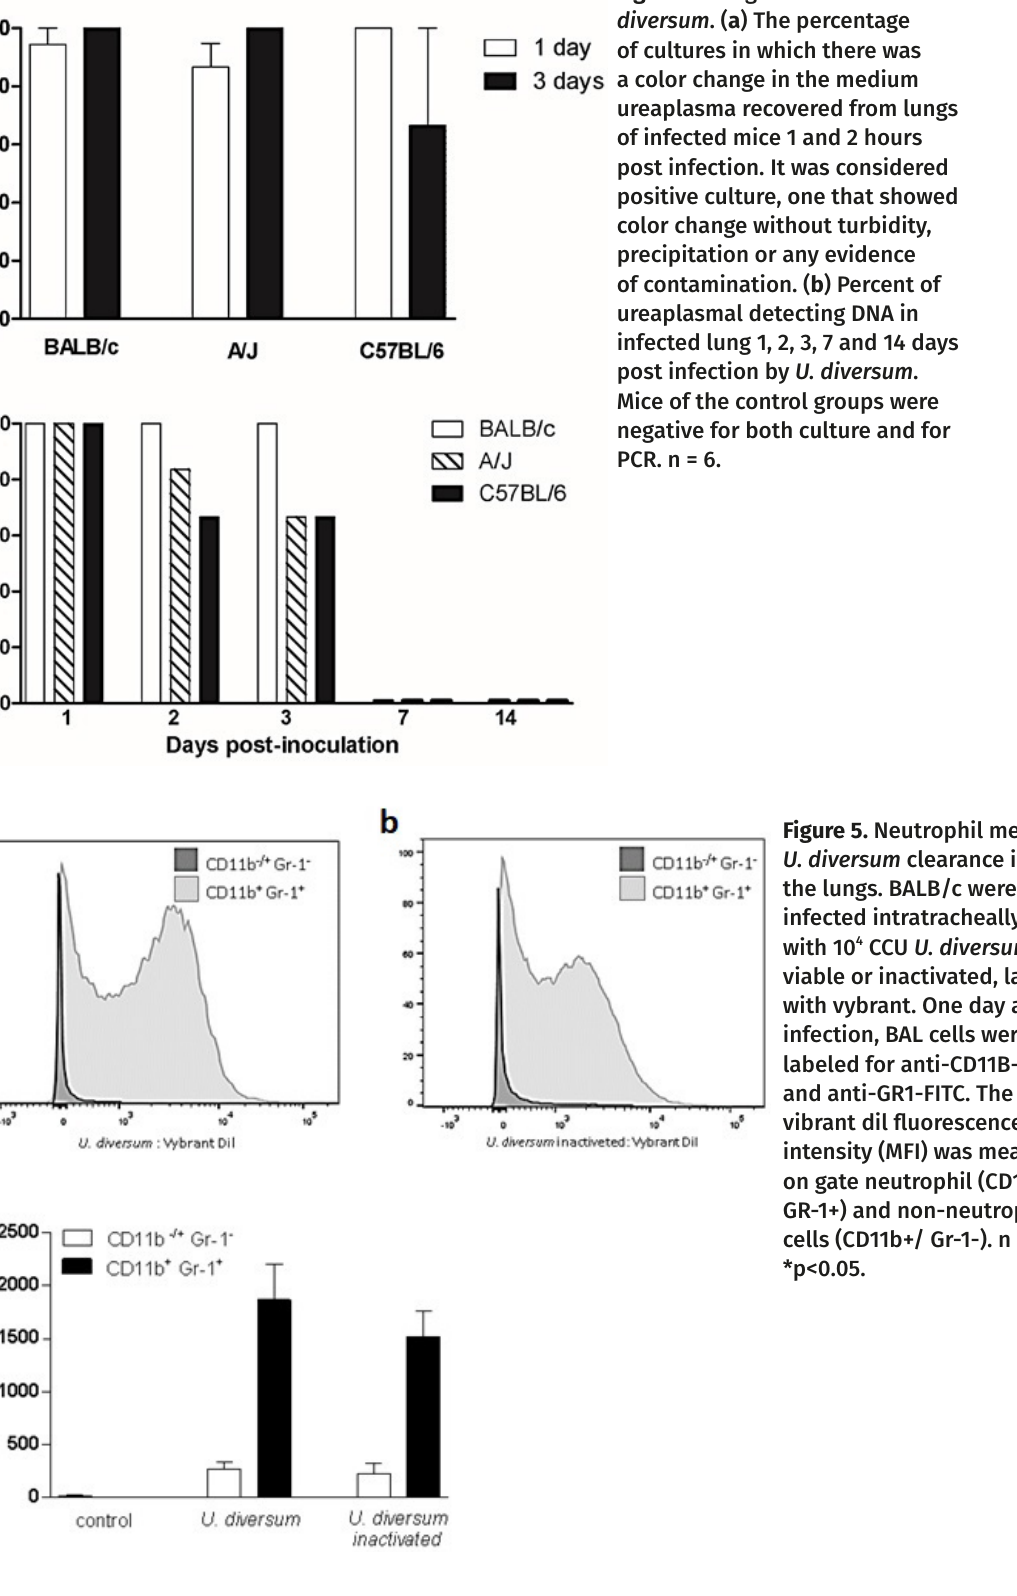
Figure 4. Lung detection of U. diversum . ( a ) The percentage of cultures in which there was a color change in the medium ureaplasma recovered from lungs of infected mice 1 and 2 hours post infection. It was considered positive culture, one that showed color change without turbidity, precipitation or any evidence of contamination. ( b ) Percent of ureaplasmal detecting DNA in infected lung 1, 2, 3, 7 and 14 days post infection by U. diversum . Mice of the control groups were negative for both culture and for PCR. n =